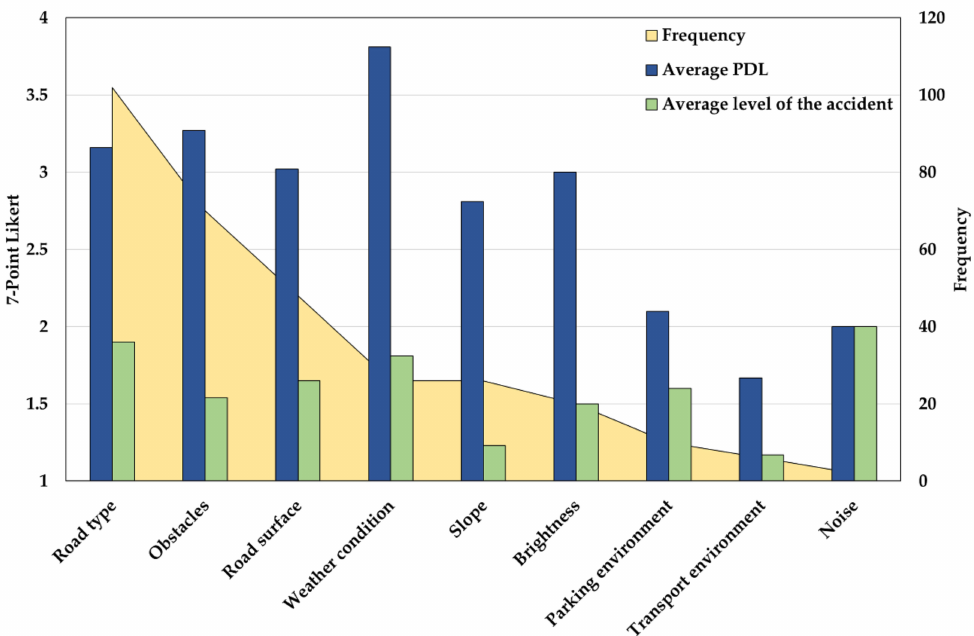
Figure 5. Episode distributions and average scores relying on the “environmental